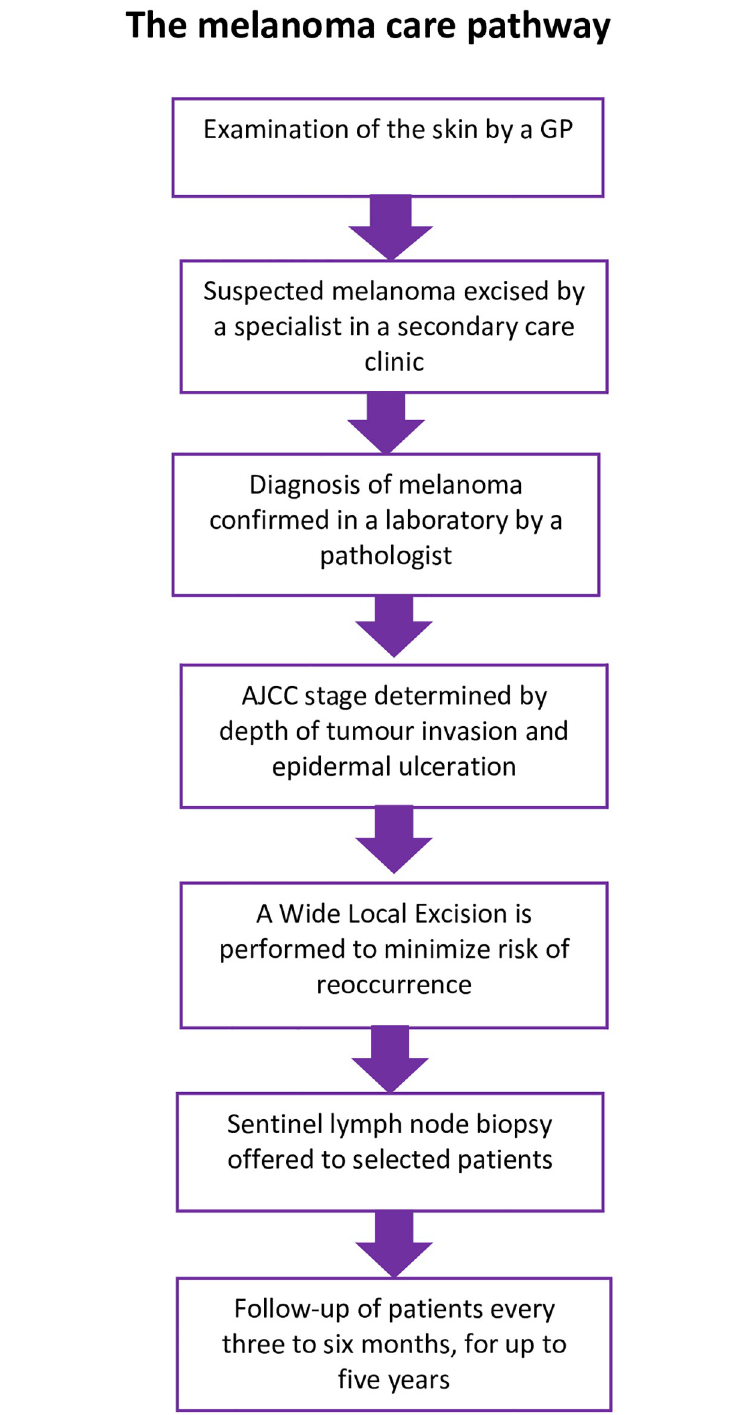
Fig 1. Melanoma care